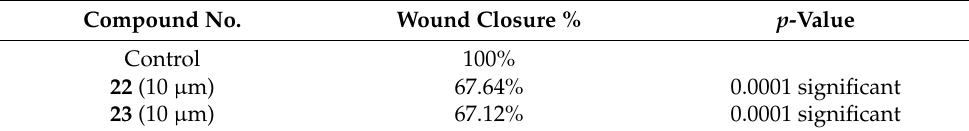
Table 3. Effect of treatment on A549 cells migration.